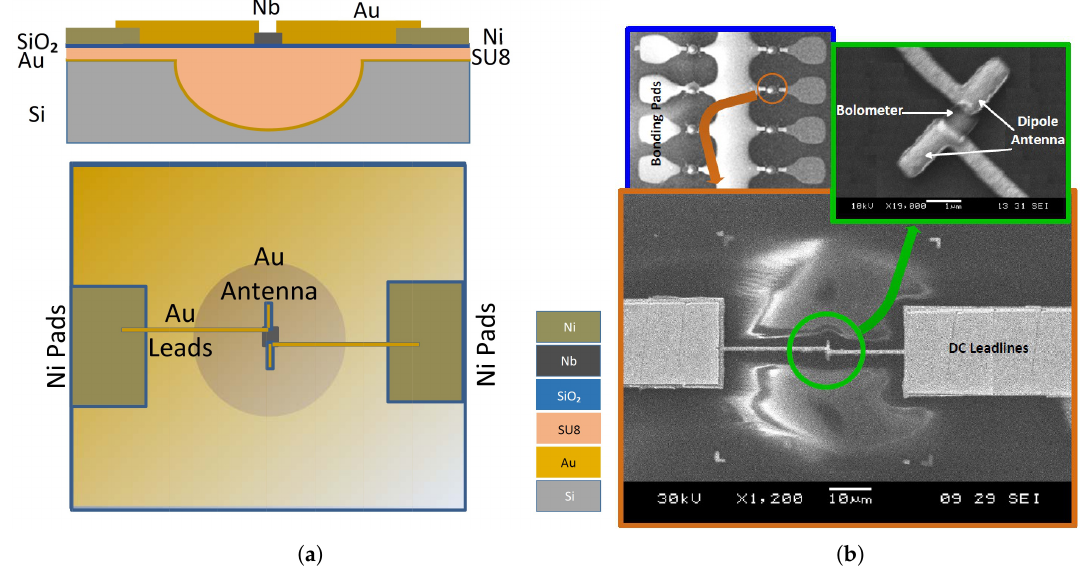
Figure 9. Parabolic reflector cavity backed structure: ( a ) Demonstrative diagram ( b ) Scanning electron micrograph (SEM) of a complete integrated device